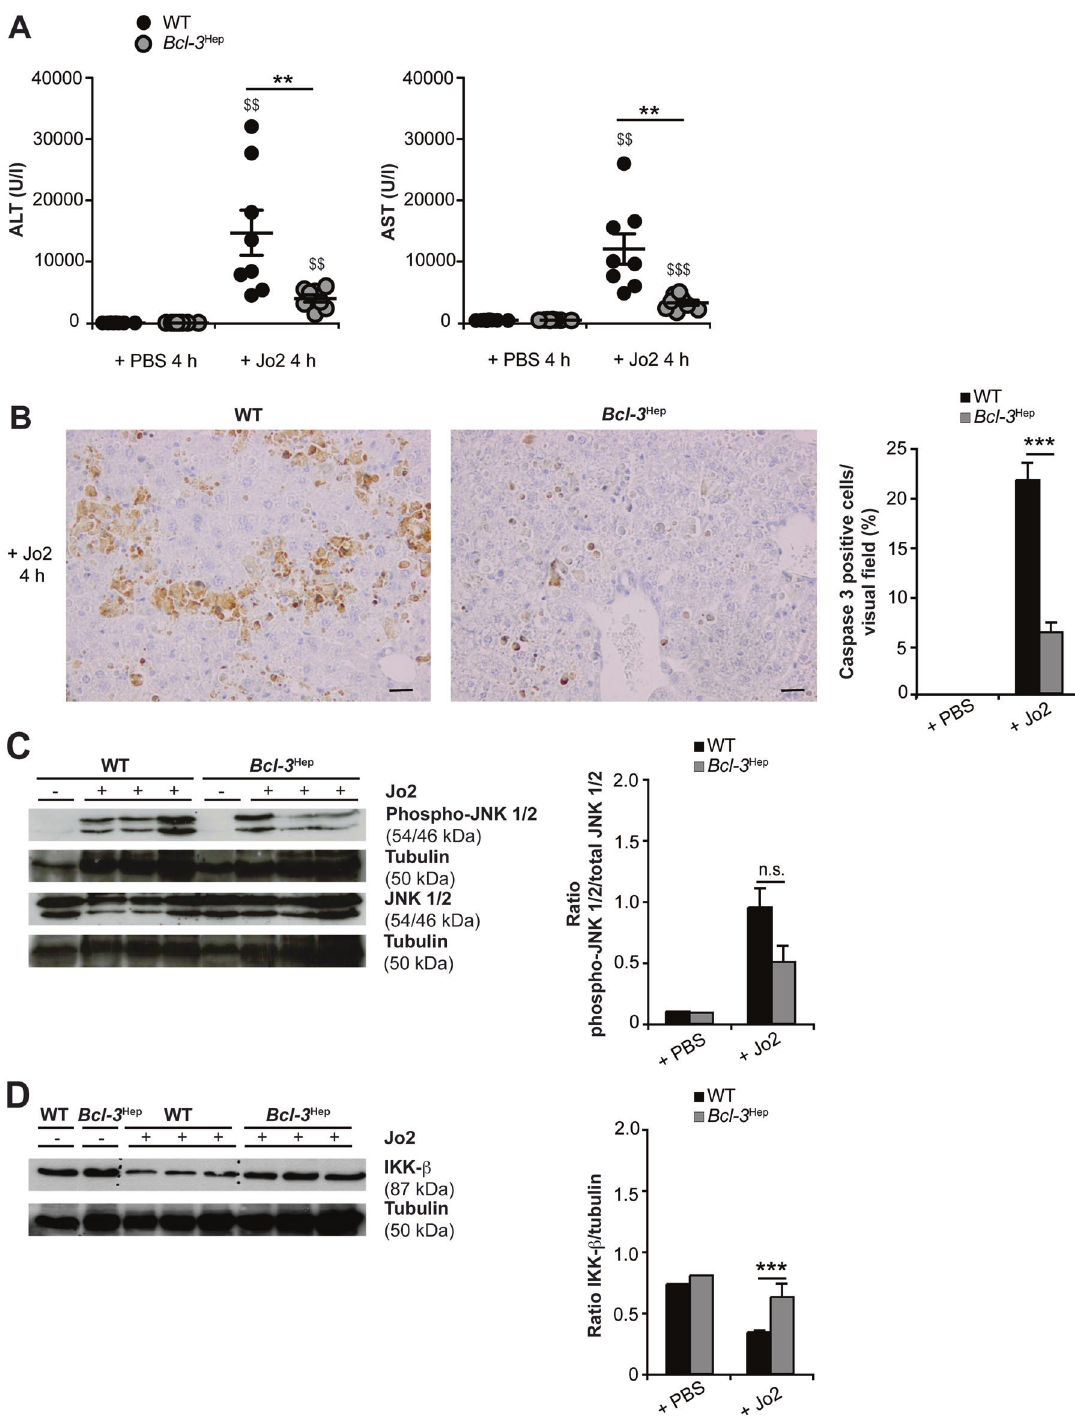
Fig. 6 Agonistic anti-FAS (CD95/APO-1) antibody Jo2-induced acute liver injury is attenuated in Bcl-3 Hep mice. Liver injury was assessed by measurement of A serum ALT and AST levels and B caspase 3 activity on liver histology at 4 h post Jo2. C Hepatic JNK activity and D IKK- β expression were analyzed by immunoblotting in whole liver tissue lysates. Data in A represent means ± SEM from two experiments with a total of n = 8 WT + Jo2, n = 8 Bcl-3 Hep + Jo2, n = 7 WT + PBS, and n = 7 Bcl-3 Hep + PBS. In B representative histological photomicrographs (scale bar: 2000 µM) are depicted. In C and D representative western blots with densitometric analysis are shown. ** p < 0.01, *** p < 0.001 for WT vs. Bcl-3 Hep and $$ p < 0.01, $$$ p < 0.001 for PBS vs. Jo2 using Mann – Whitney U test ( A : ALT) or unpaired, two-tailed Student ’ s t -test ( A : AST and B – D ). In C there was no statistical difference between the two groups in respect of JNK activation. sequencing (RNA-seq) analysis revealed that under 981 genes differentially hit: 893) and Fas (logFC = 0.63, p < 0.01, hit: 485), which encode TNF-R2 expressed (@ FDR p < 0.05) in liver between naïve 8-week old Bcl-3 Hep and and FAS (CD95/APO-1), resp., was signi fi cantly increased in Bcl-3 Hep livers WT mice no signi fi cant differential expression of Tnfrsf1a encoding TNF-R1 [14]. Bcl-3 knockout mice ( Bcl-3 KO) were kindly provided by Dr. Hana Algül was detected. However, gene expression of Tnfrsf1b (logFC = 0.63, p < 0.05, (Technical University Munich, Germany). All animals were bred at the Cell Death and Disease (2022)